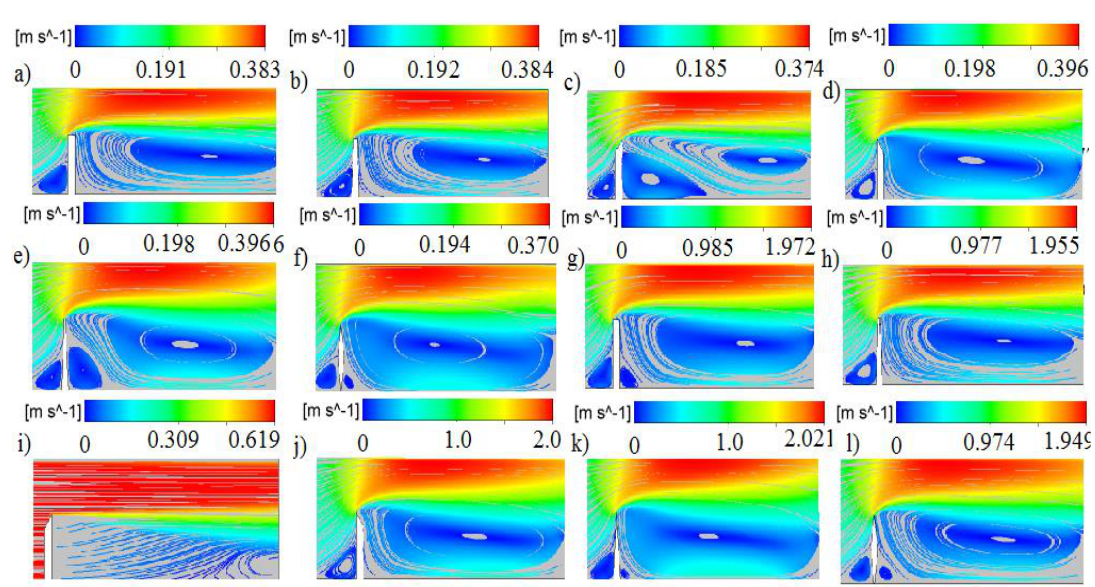
Figure 4. Streamlines for different baffles at Re = 20, 000 [a-f] and Re = 1, 00, 000 [g-l].